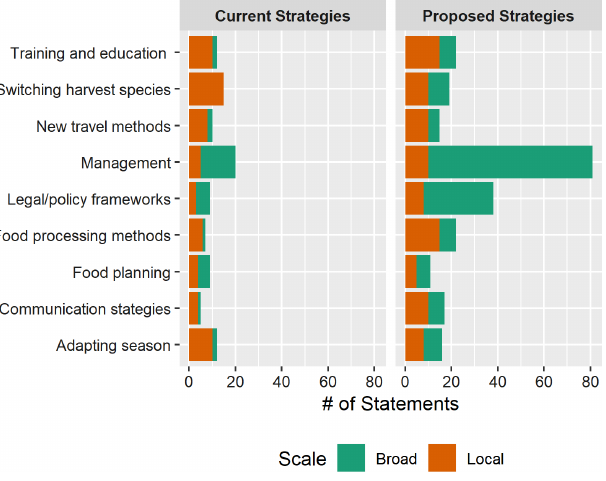
Fig. 6 . Number of harvester statements that addressed both current and proposed climate-related adaptation strategies to wild food harvest. Adaptation strategies were recorded at the local scale (i.e., adaptations from within communities or user groups, orange bars), and at the broad scale (i.e., outside the jurisdiction of user groups, green